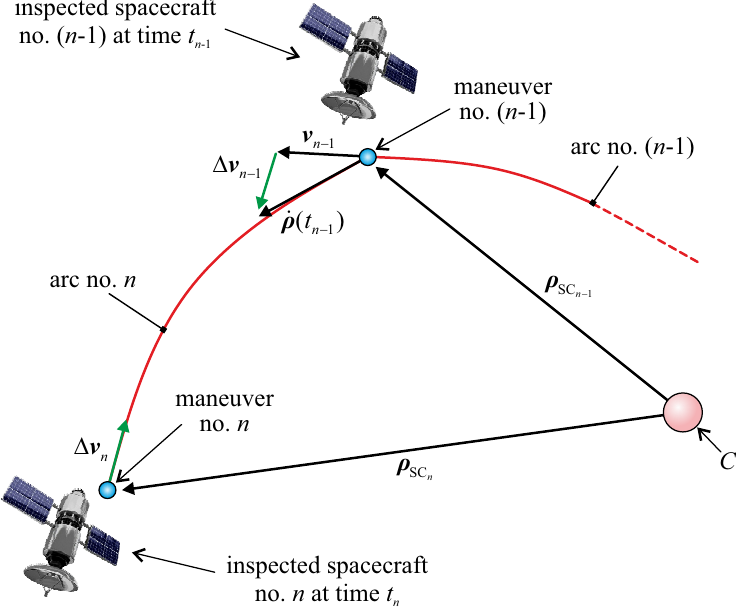
Figure 6. Last two arcs and impulsive